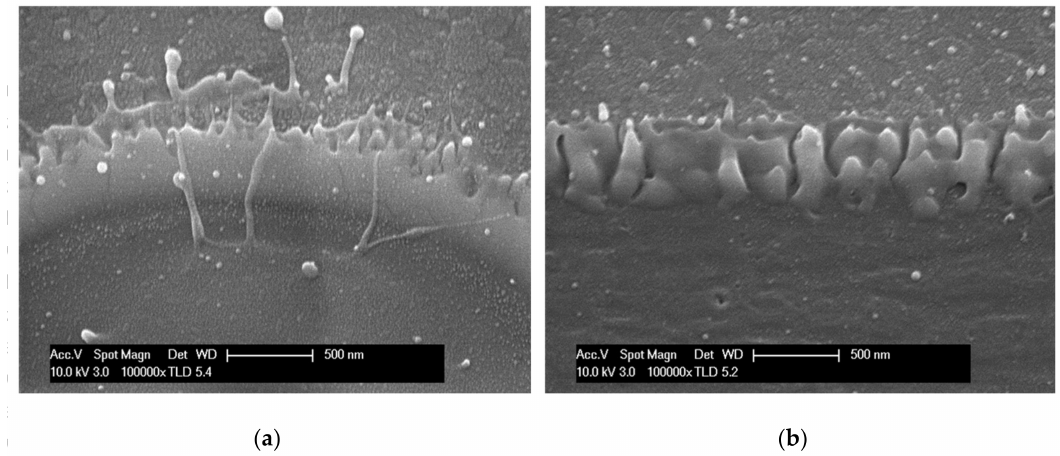
Figure 4. SEM images ( a ) with Gaussian beam irradiation and ( b ) with the quasi-flat top beam, measured by tilting the pattern.